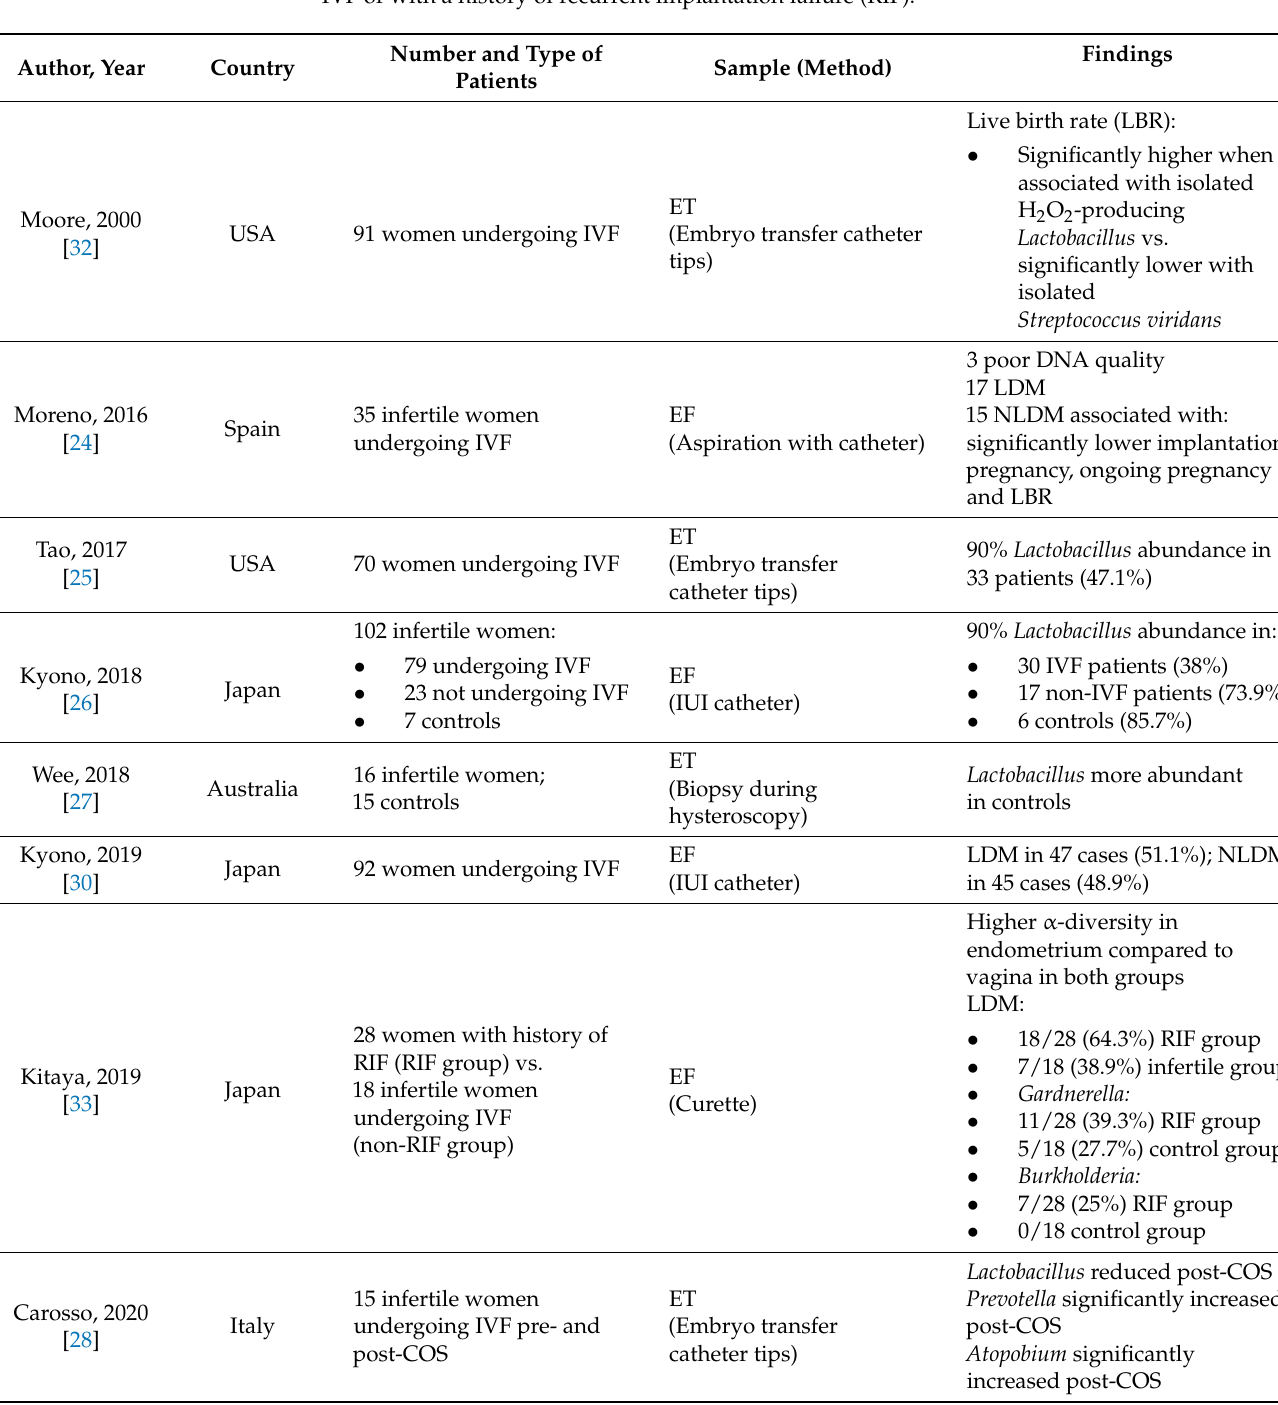
Table 1. Endometrial microbiome composition in infertile women, including patients undergoing IVF or with a history of recurrent implantation failure